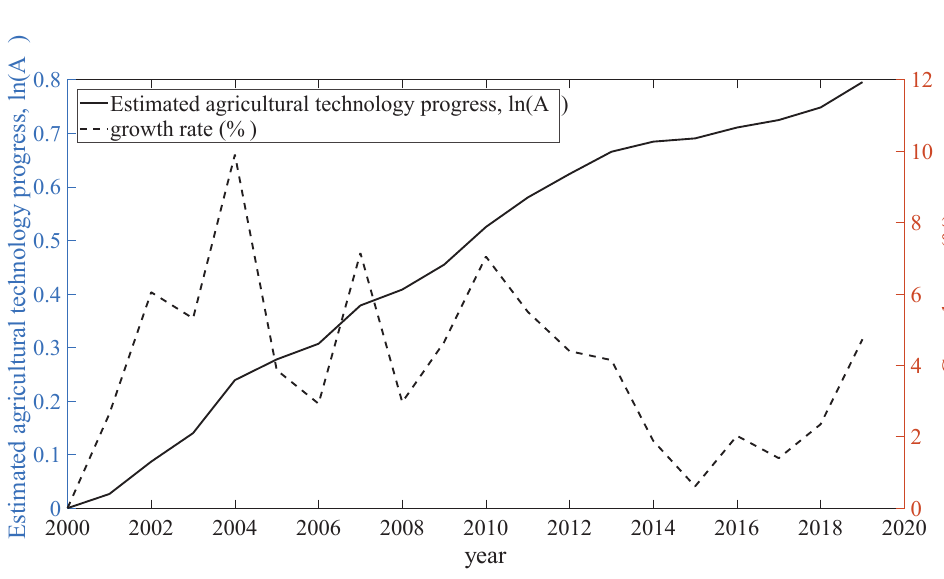
Figure 3. Trend of the ATP in China